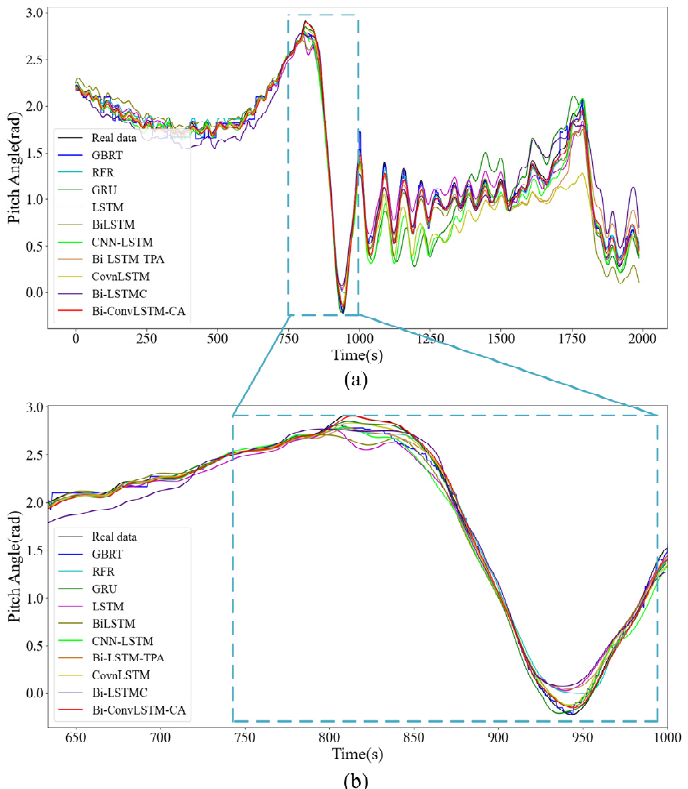
Figure 11. Ship pitch angle prediction results of Bi-ConvLSTM-CA model. ( a ) Ship pitch angle prediction results of Bi-ConvLSTM-CA model in 0–2000 s; ( b ) Ship pitch angle prediction results of Bi-ConvLSTM-CA model in 810–1000 s.